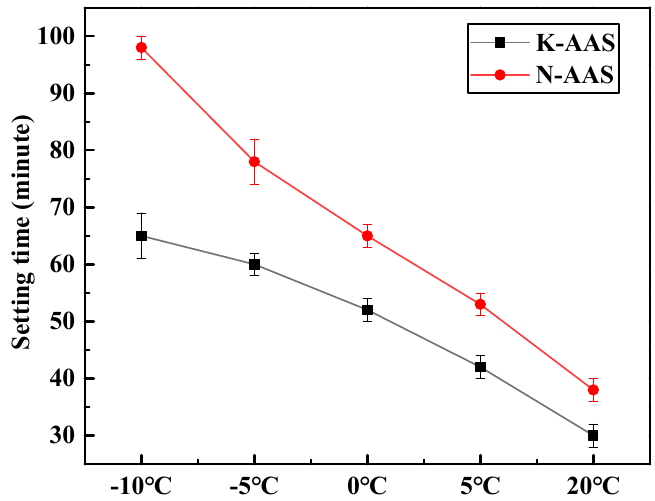
Figure 2. Setting time of K-AAS mortar and N-AAS mortar at different temperatures.